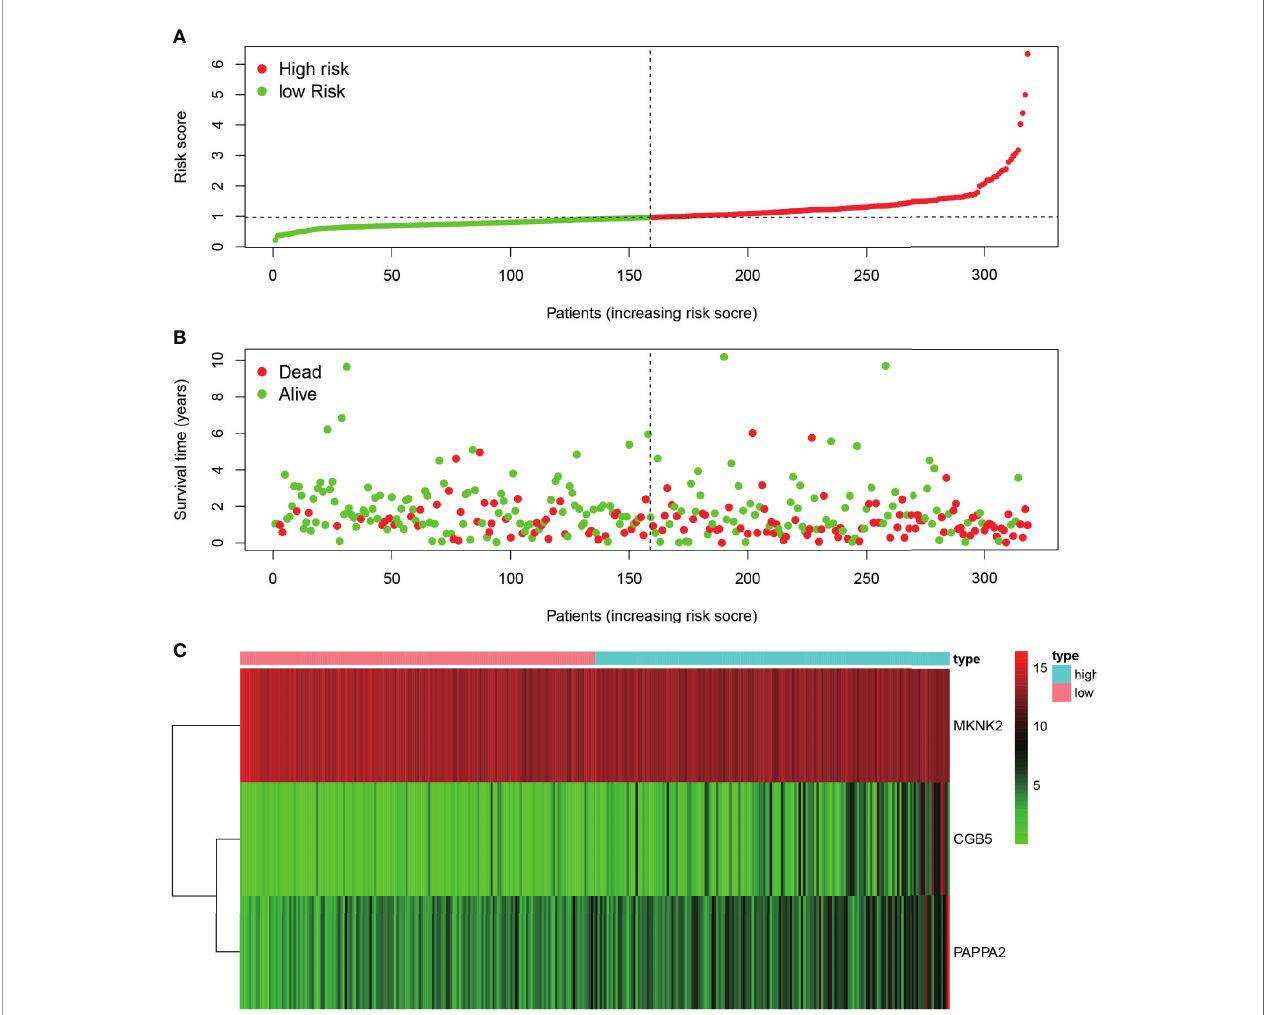
FIGURE 9 | Riskiness assessment. Chart (A) represents the ranking of all patients in order from low risk to high-risk line based on the level of risk. Chart (B) indicates the survival of individual patients, with red dots indicating death and green dots indicating survival. (C) -plots indicate the gene expression of the three genes used to construct the model in each